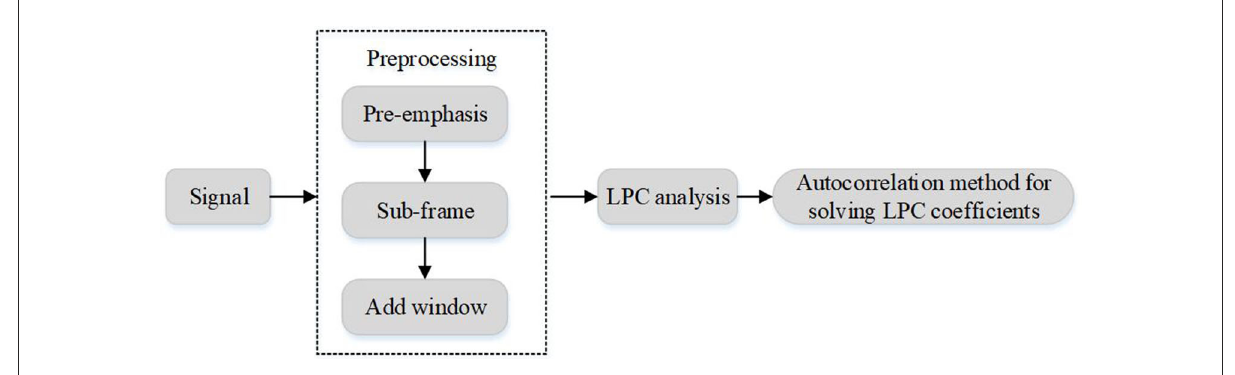
FIGURE2 LPC coefficient extraction